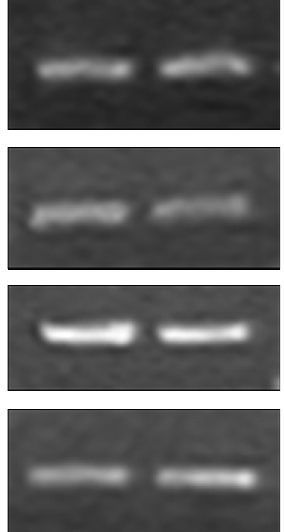
Figure 7 - Expression analysis of Spl5 , Spl11 and Spl28 by assessed by